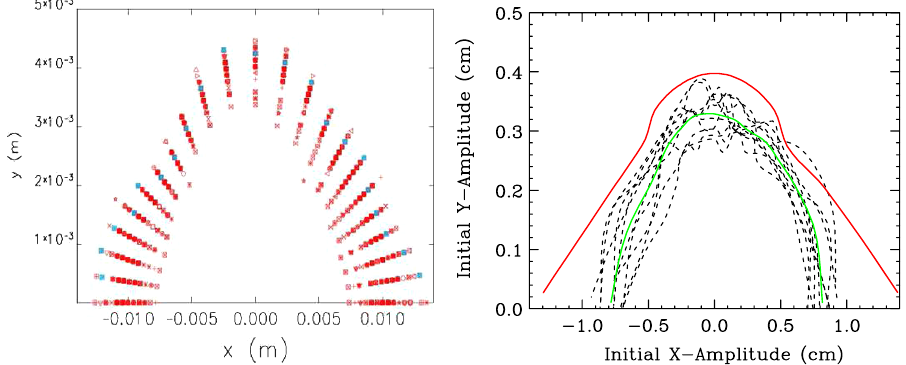
ULTIMATE STORAGE RING BASED ON FOURTH-ORDER . .